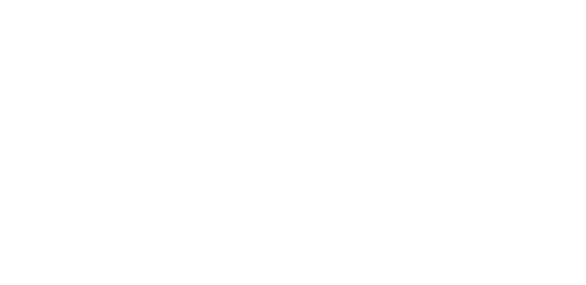
Table 2. Characteristics of isolated sdAb.